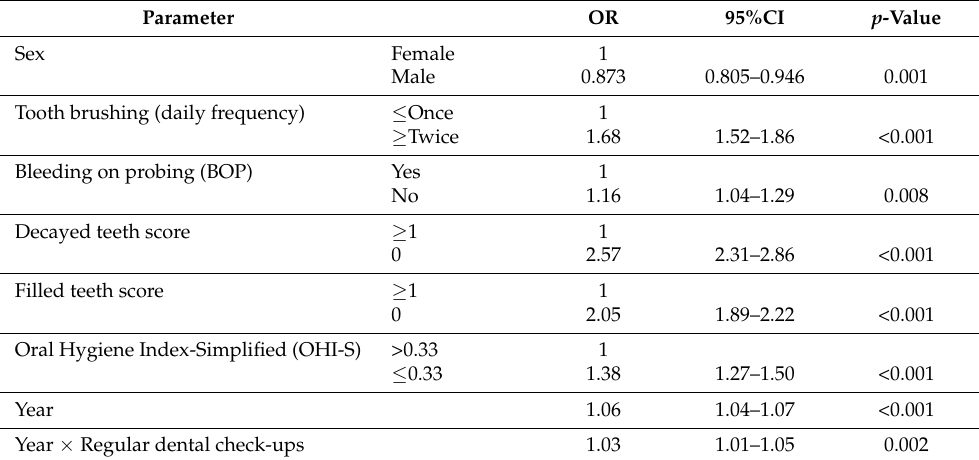
Table 5. Factors associated with self-rated oral health (very good, good, and fair) on logistic regression analyses in 2011–2019, adding survey year and interactions with survey year, Japanese university students.